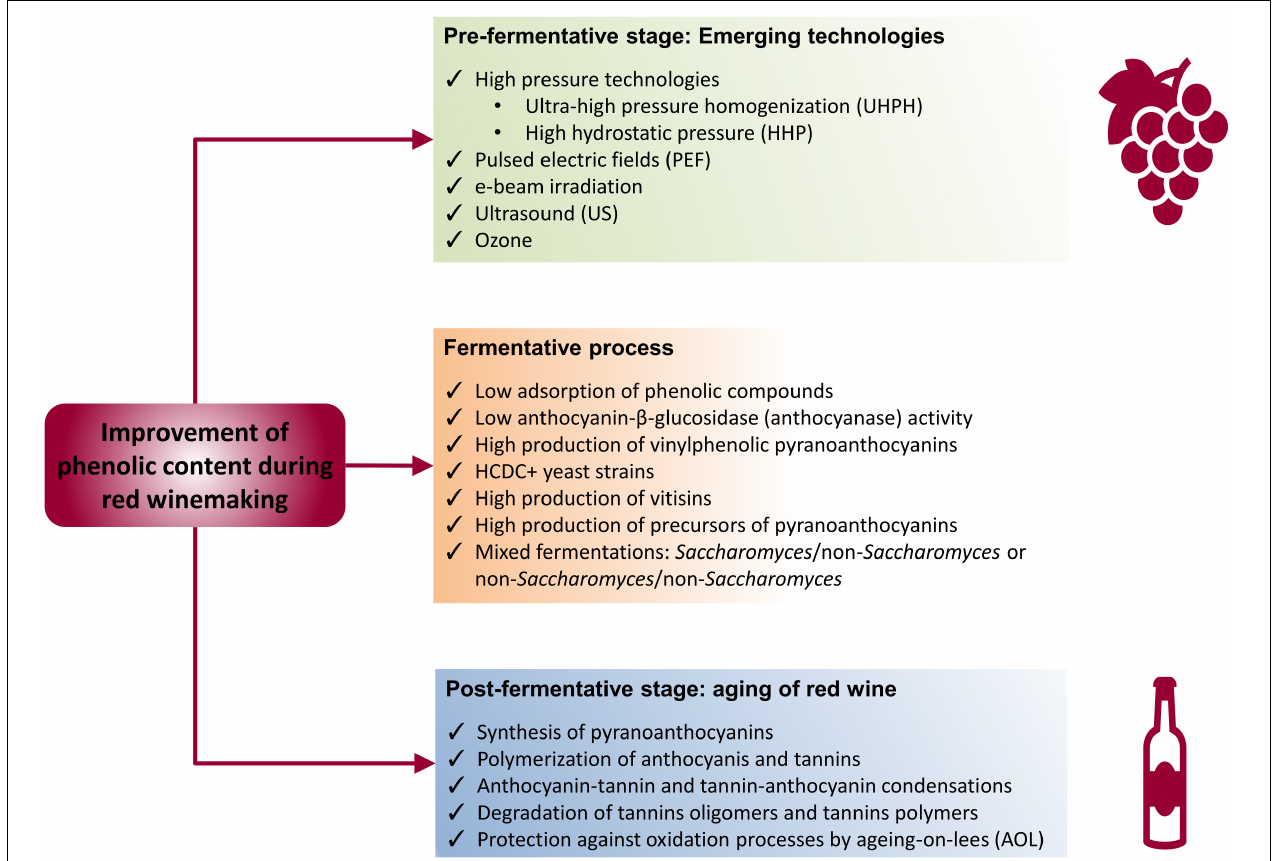
FIGURE 3 | Technological strategies to improve the content of phenolic compounds during red winemaking.